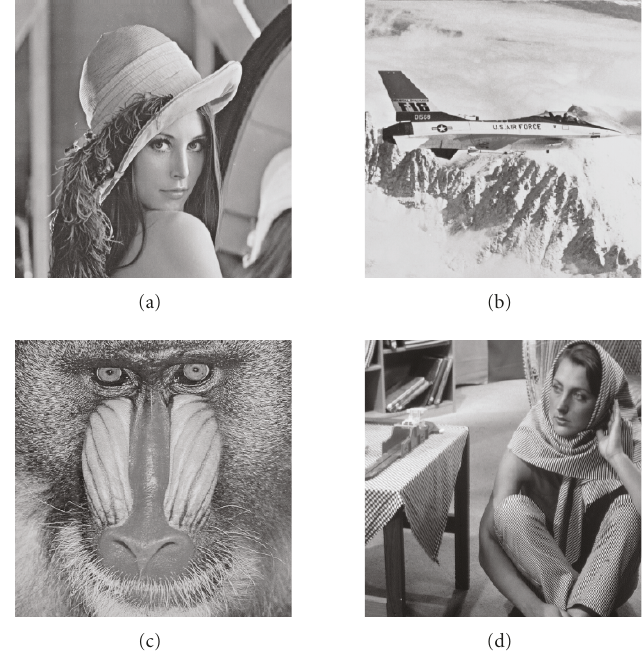
Figure 4: Four original images: (a) Lena , (b) Jet, (c) Baboon, (d)